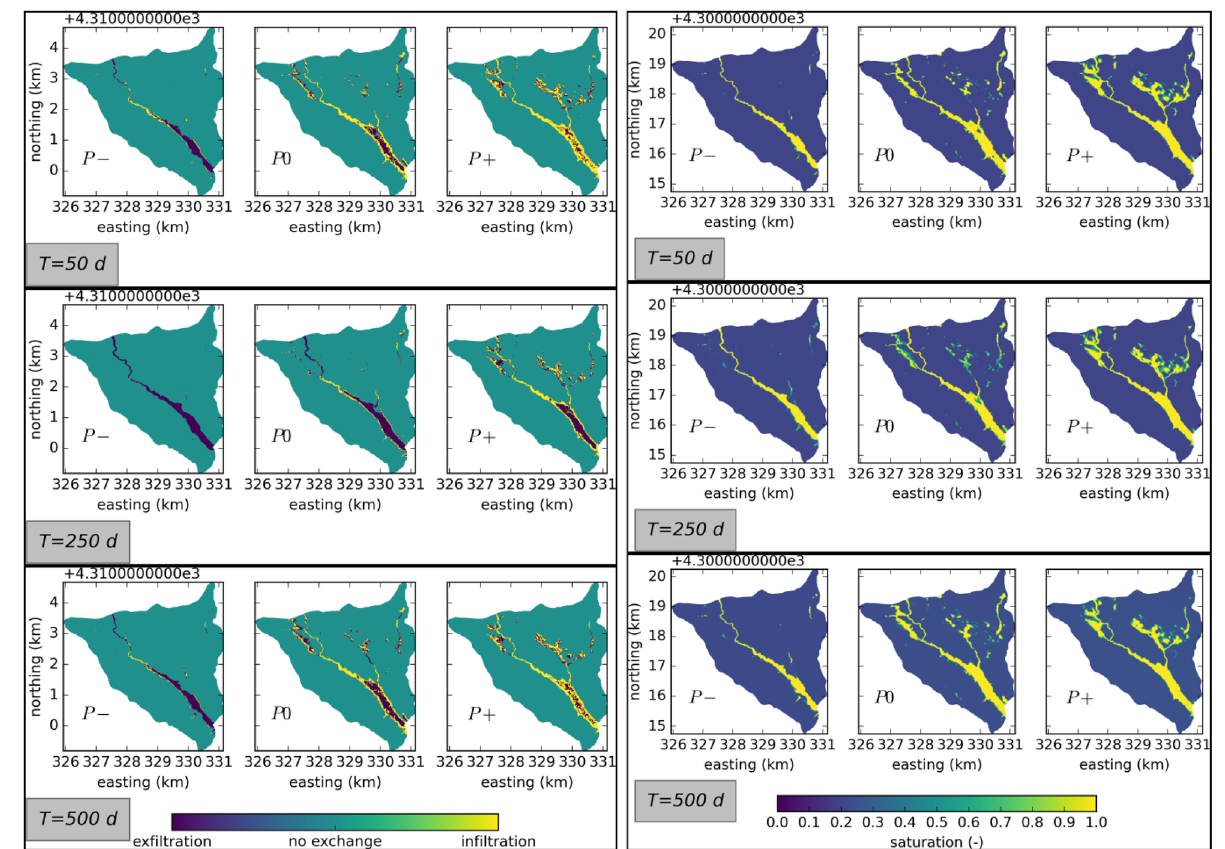
Figure 2. Left: snapshots of the spatial patterns of infiltration and exfiltration at the surface. Right: snapshots of the spatial patterns of soil saturation in the top layer. T = 50 d: low flow conditions in the first water year, T = 250 d: rising limb in the first water year, T = 500 d: low flow conditions in the second water year, shortly before the rising